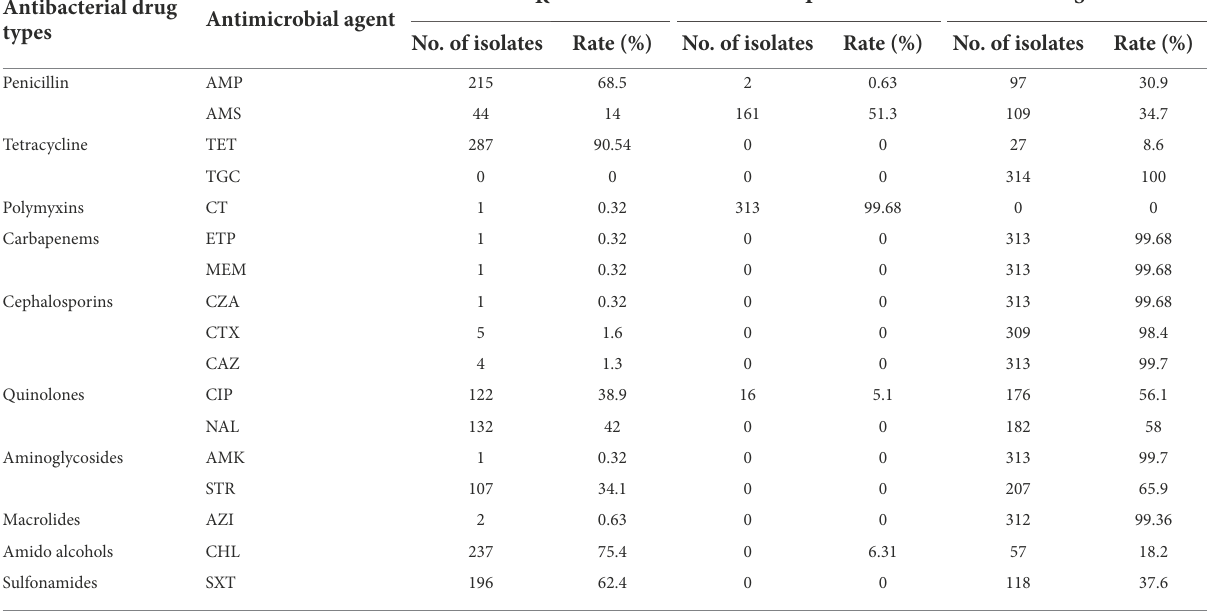
TABLE 2 Drug-resistant phenotypes of S. Derby ST40 strains ( n = 314). Antibacterial drug